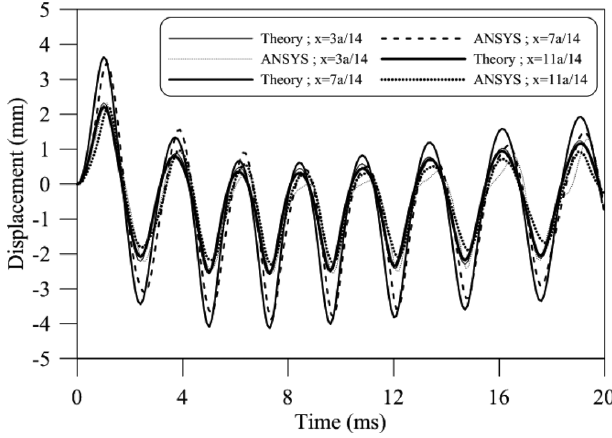
Fig. 6. The displacement-time histories of the simply-supported tapered laminated plates ( β = 0.7).